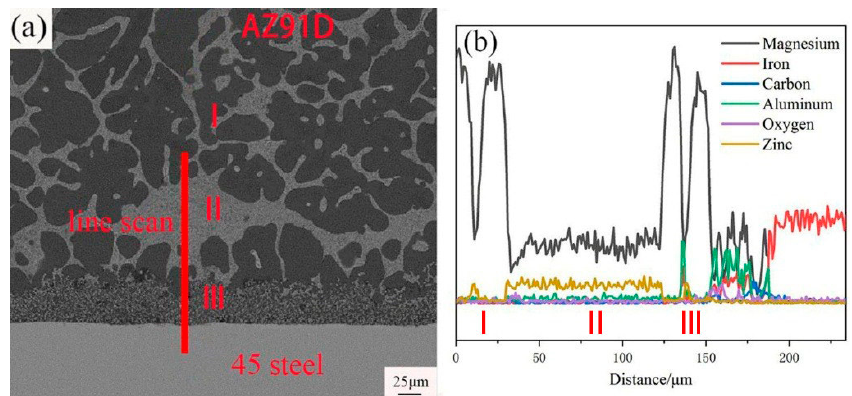
Figure 5. ( a ) SEM micrograph of interface in galvanized-steel/AZ91D; ( b ) EDS line scan of galvanized-steel/AZ91D interface marked in (a).